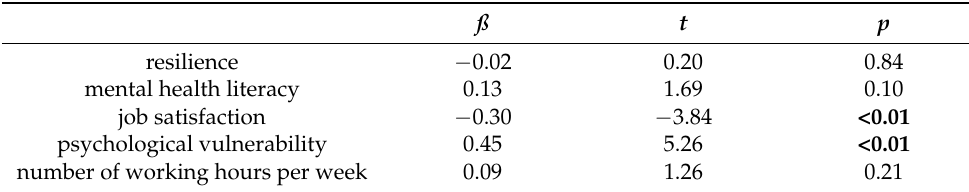
Table 2. Influence of the potential protective and vulnerability factors on municipal workers’ depres- sive symptoms.